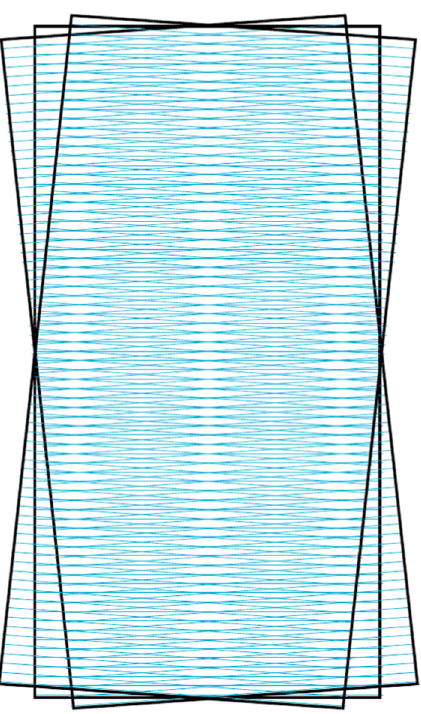
Fig. 2 Schematic drawing of the three “views” that compose each straw chamber